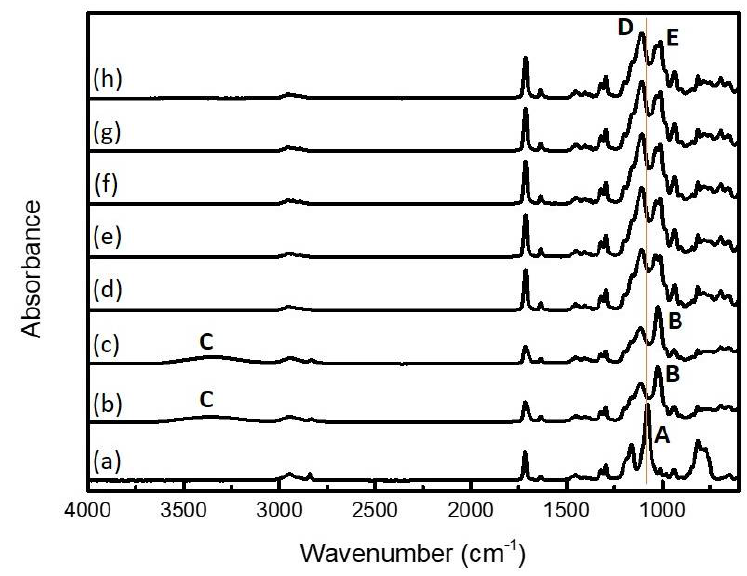
Figure 2. FT-IR spectra of LMO during sol–gel reaction: ( a ) MPTMS silane before sol–gel reaction; hydrolysis ( b ) 30 min and ( c ) 1 h; condensation ( d ) 1 h; ( e ) 2 h; ( f ) 3 h; ( g ) 6 h; and ( h ) 72 h.